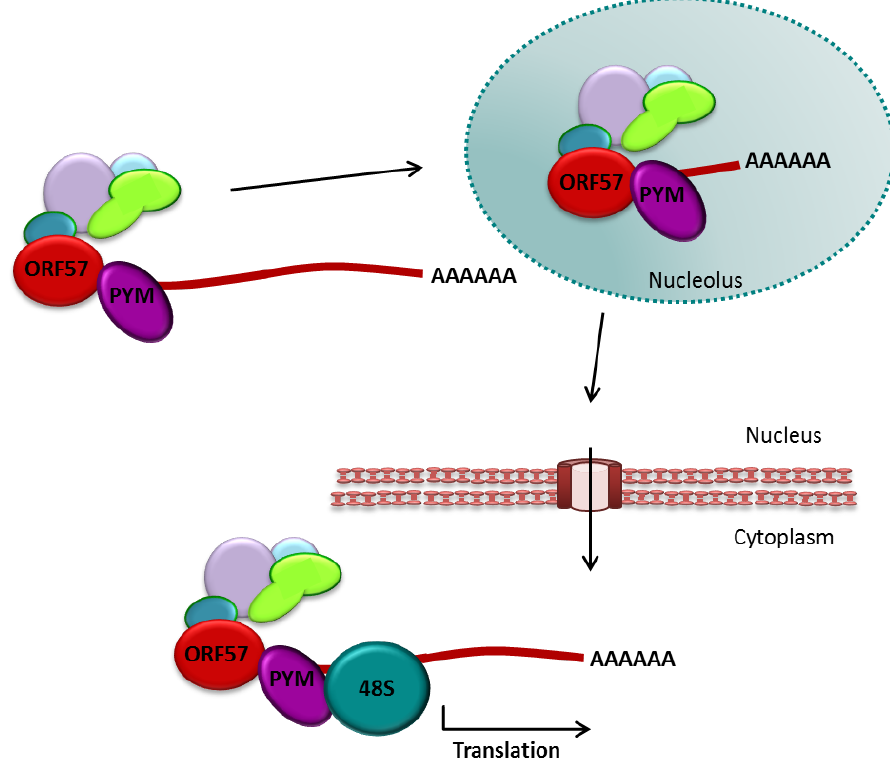
Figure 6. ORF57 interacts directly with PYM to enhance